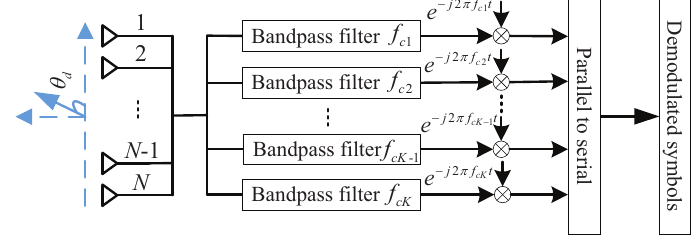
Figure 6. The architecture of the LU for the proposed DM based on a multi-carrier multiple antenna arrays